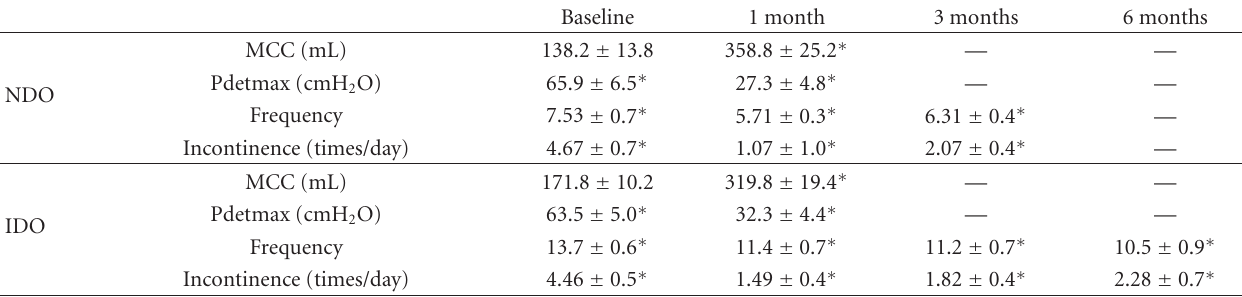
Table 1: Change of parameters before and after intradetrusor NTX treatment of NDO and IDO patients.